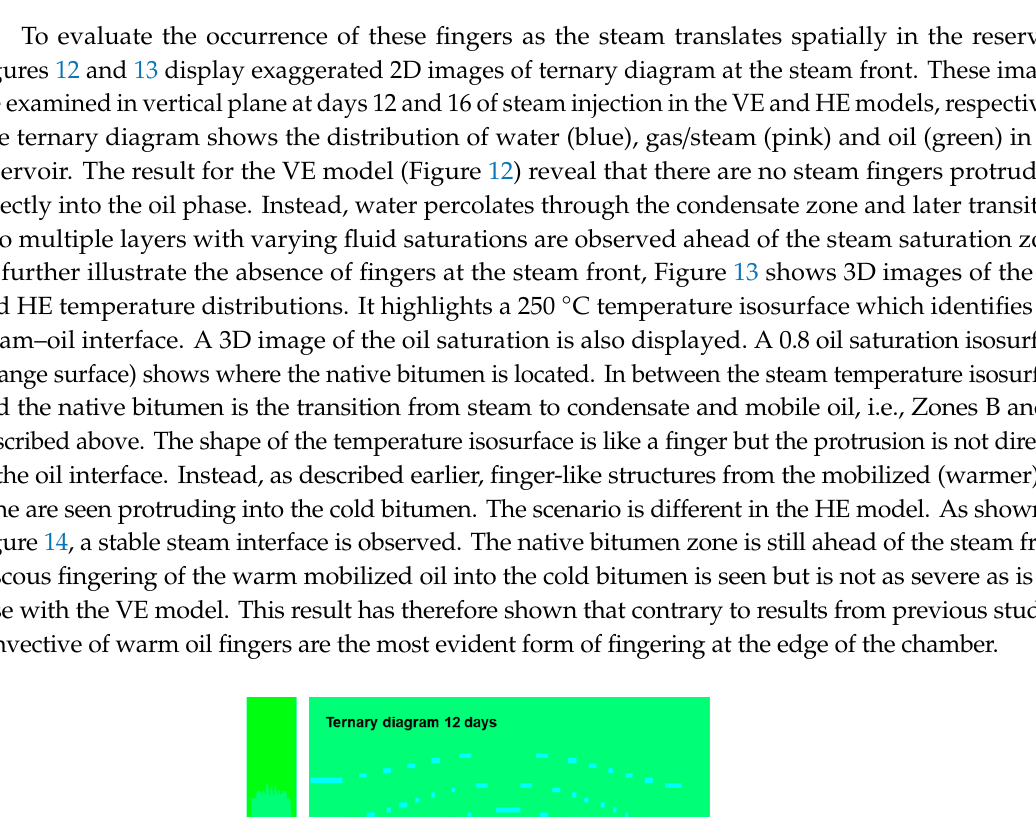
Figure 13. Cross section of the ternary diagram for the HE model. A section of the 2D image indicated by black dashed square has been zoomed in. Figure 14. 3D images of the temperature and oil saturation isosurfaces of the VE (top) and HE (bottom) models respectively. The red isosurfaces are at 250 °C indicating the steam saturation boundary. The orange isosurfaces marks the 0.8 oil saturation indicating the mobile oil boundary. The enlarged images on the right show fingering of the mobilized (warm) bitumen into the cold (native) bitumen.